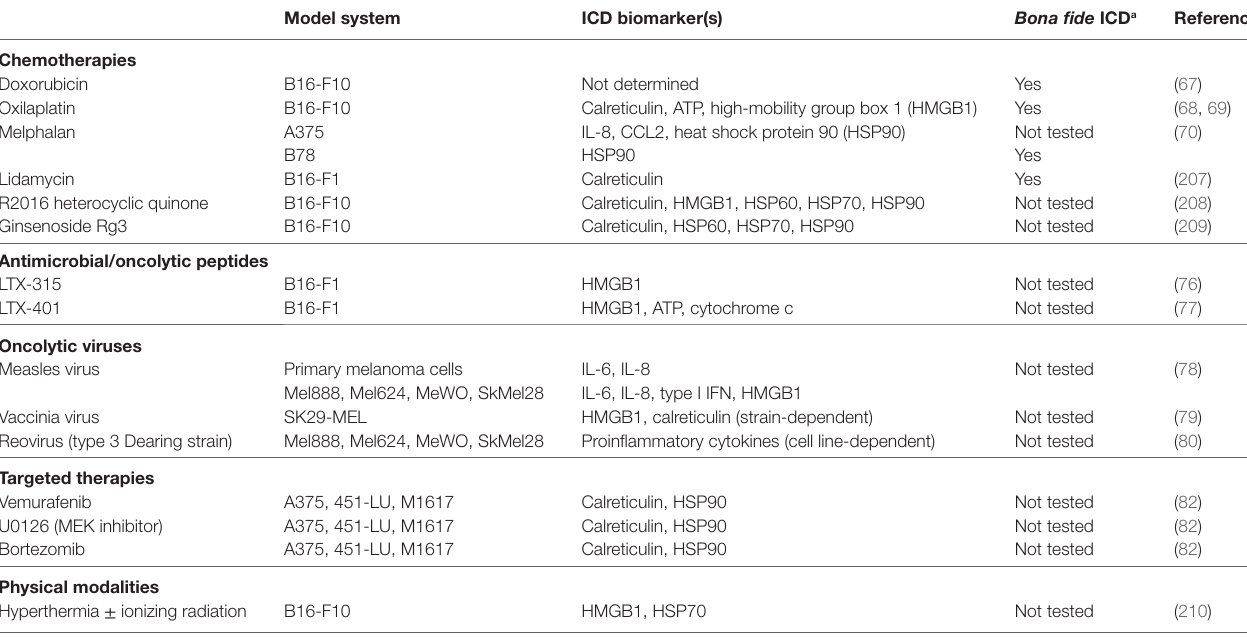
TABLe 1 | Inducers of immunogenic cell death (ICD) in melanoma. Model